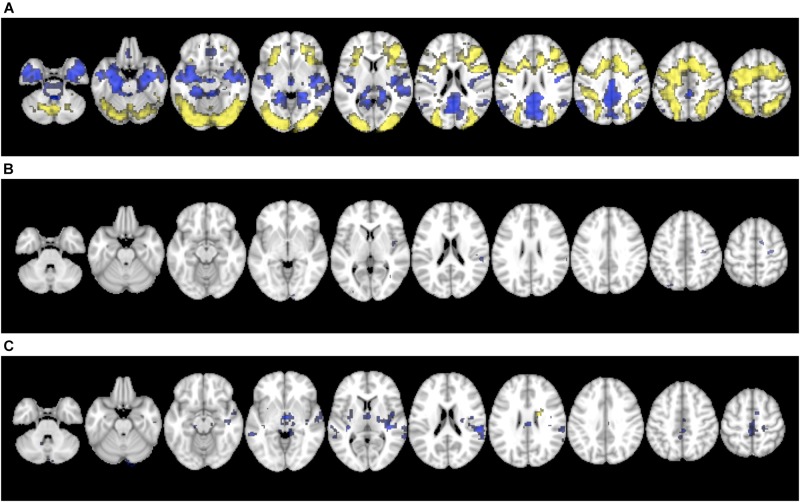
(A) Brain activation for the contrast of CDT performance vs. visual fixation. (B) Covariance with age, and (C) Covariance with performance (total score). Images were displayed in 2 mm × 2 mm × 2 mm resolution for consistency with the anatomical template.